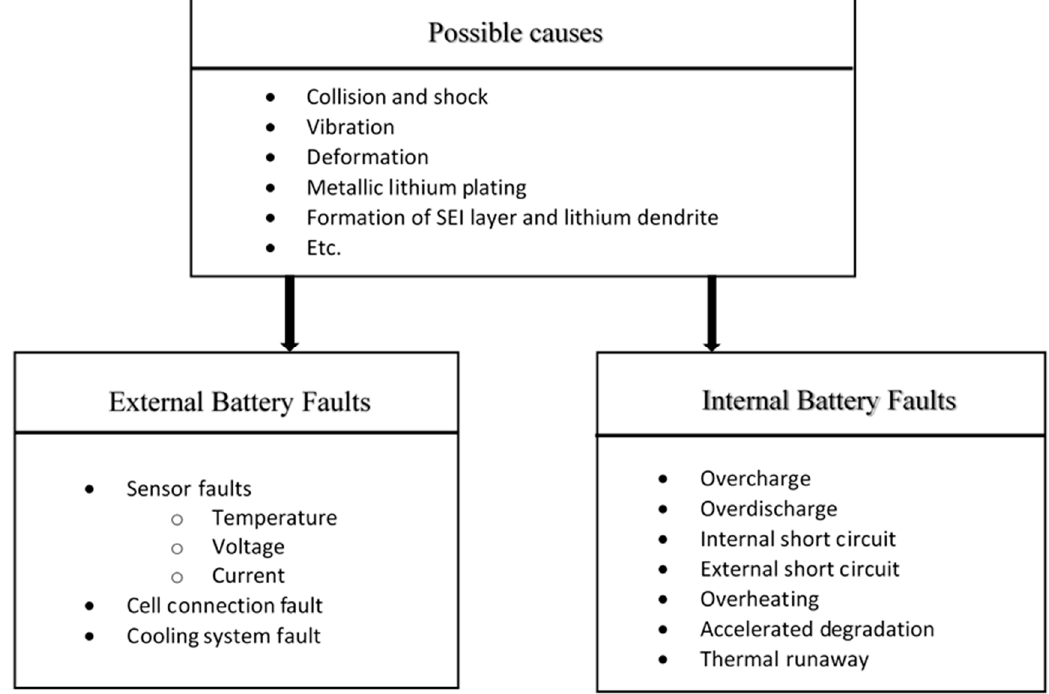
Figure 1. Internal and external Lithium-ion (Li-ion) battery faults and their causes.